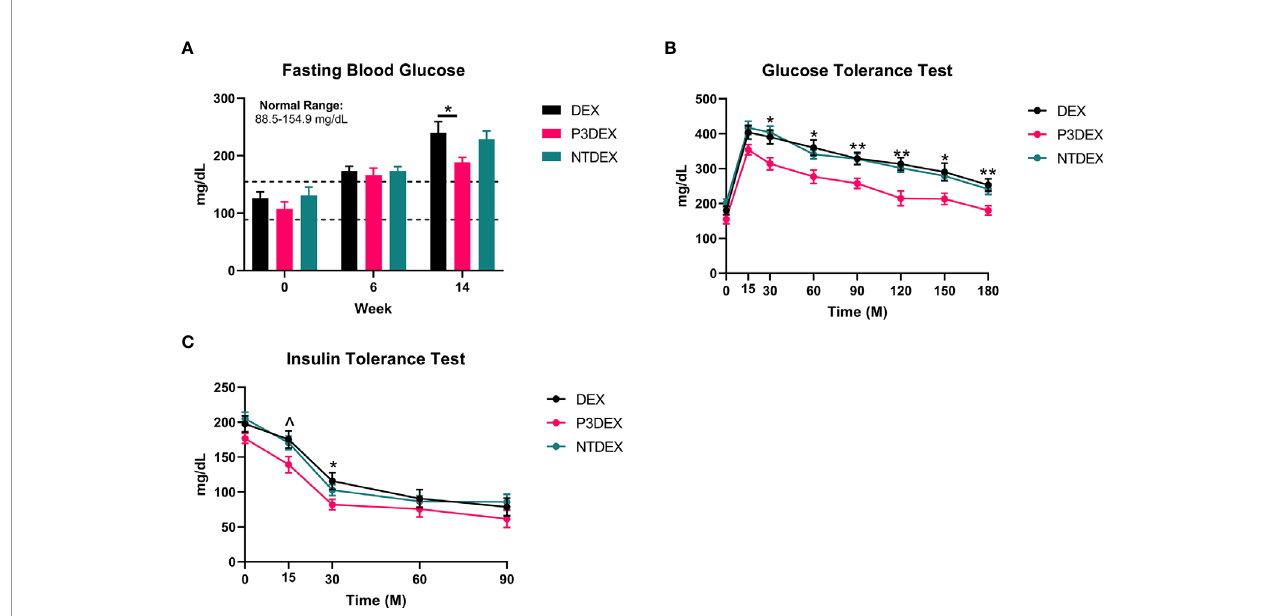
FIGURE 2 | LNFPIII conjugates improve glucose homeostasis and reduce insulin resistance. (A) P3DEX reduces fasting blood glucose levels. (B) P3DEX improves glucose tolerance. (C) P3DEX improves insulin sensitivity. Two-way ANOVA with Dunnett ’ s Multiple Comparisons Test. *indicates a signi fi cant difference between DEX and P3DEX (p ≤ 0.05). ^indicates a trend between DEX and P3DEX (p ≤ 0.10). (**p ≤